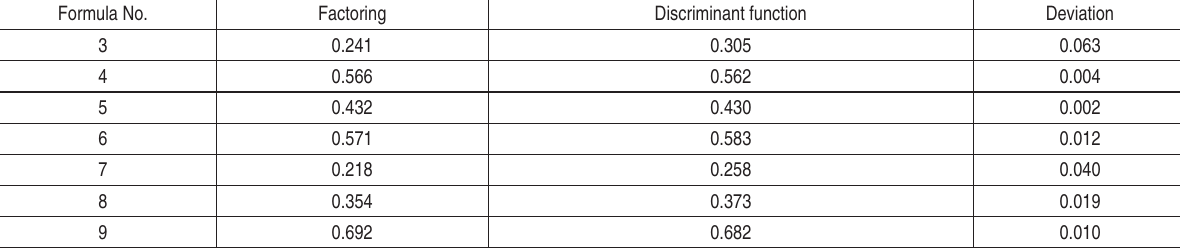
Table 7. Actual credit portfolios compared against optimal portfolios by means of similarity Formula